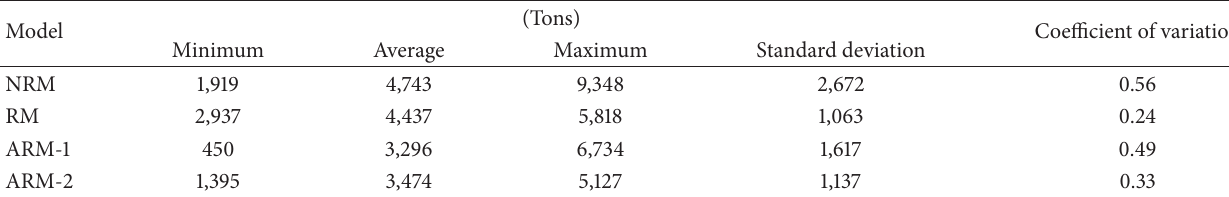
Table 4: Allocation of commodities across utilized